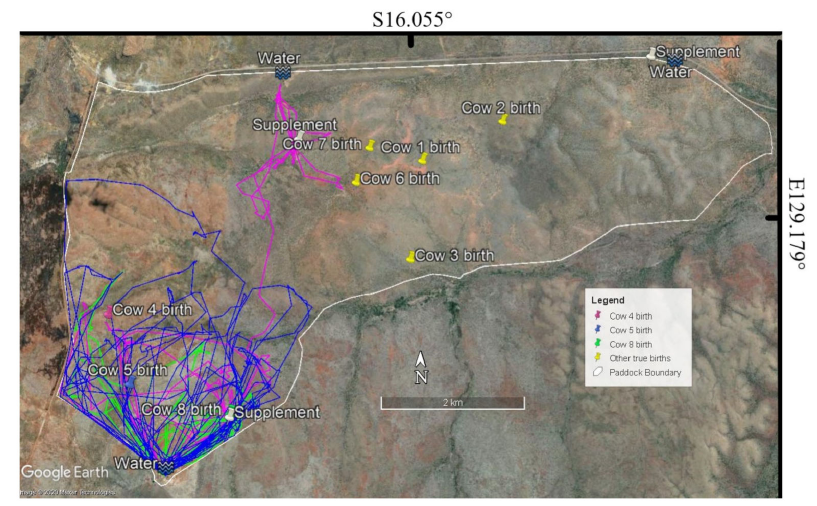
Figure 7. Satellite image showing the tracks and fixes of three cows from Trial 1, one week each side of calving. White outline shows the boundary of the paddock. The eight true birth alerts are shown with their respective collars, as well as supplement and water points within the 33 km 2